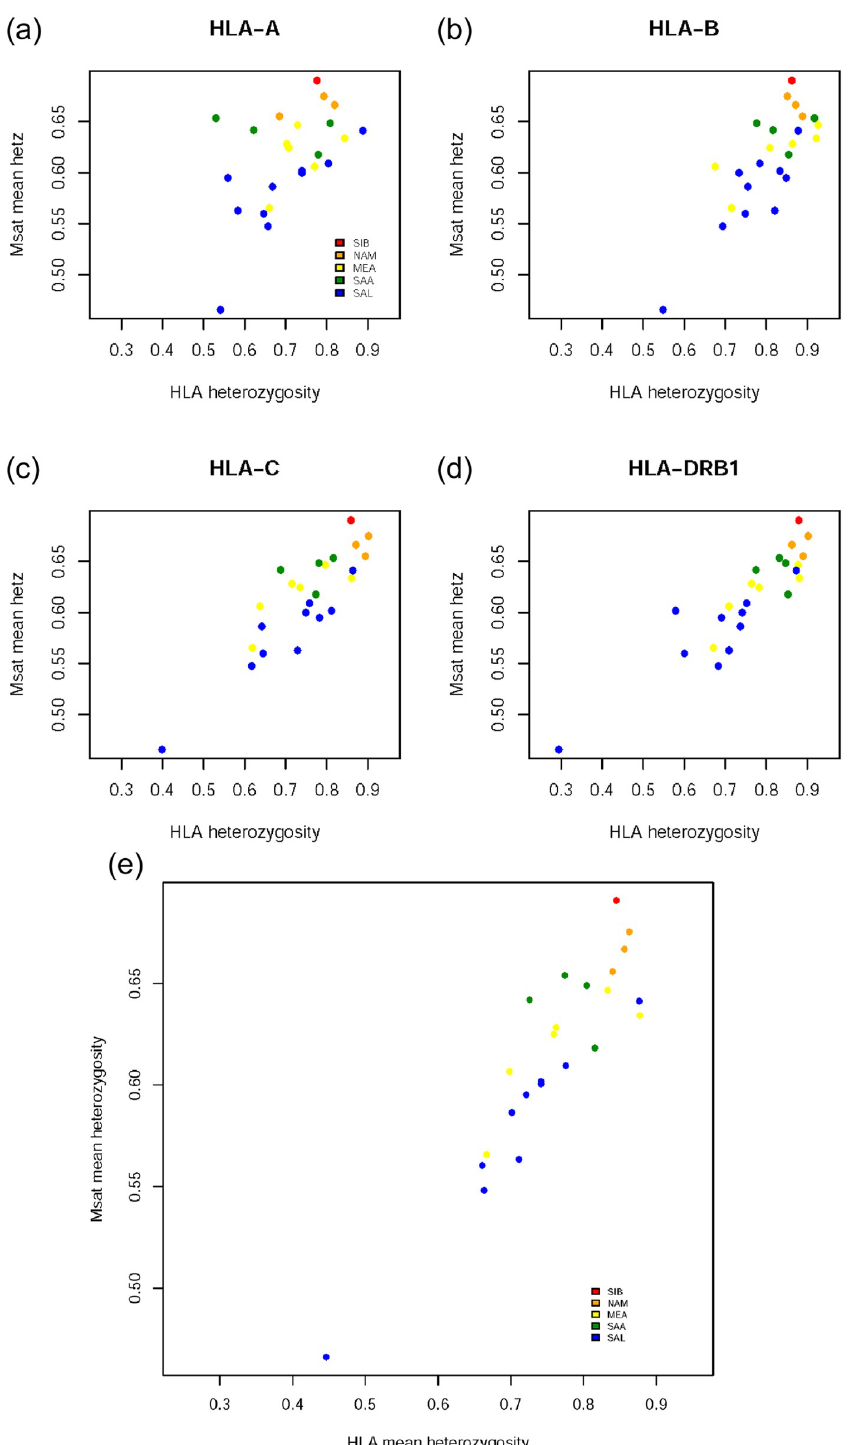
Fig 3. (a–d) Relationship between heterozygosity for microsatellites and HLA. Results are shown separately for each HLA locus in panels (a)-(d). Panel (e) shows results that are averaged over the four HLA loci.